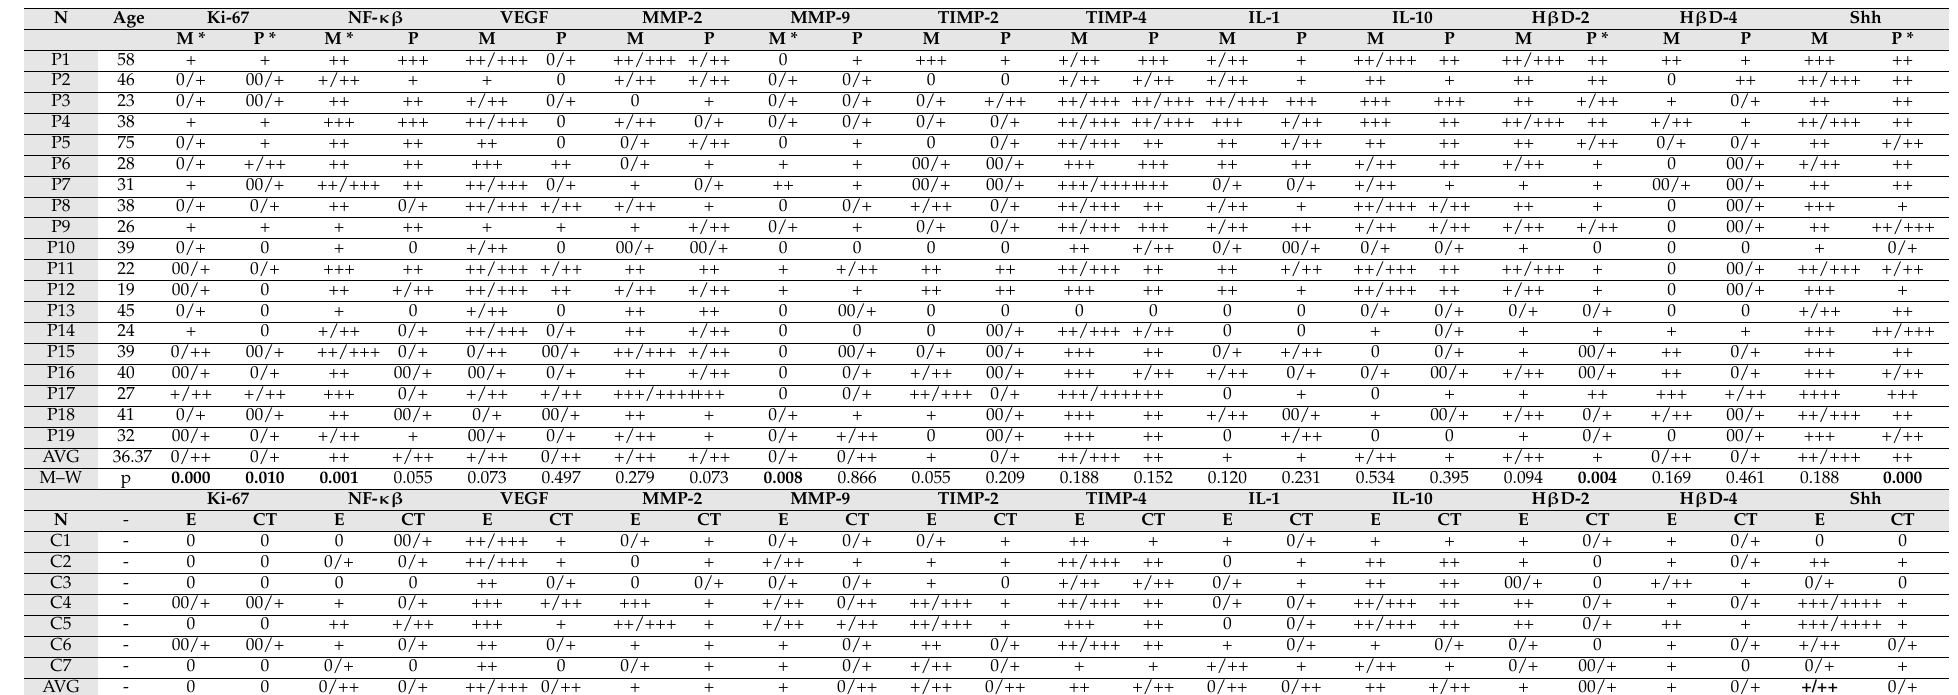
Table 1. Relative numbers of different cell factors in the patient and control